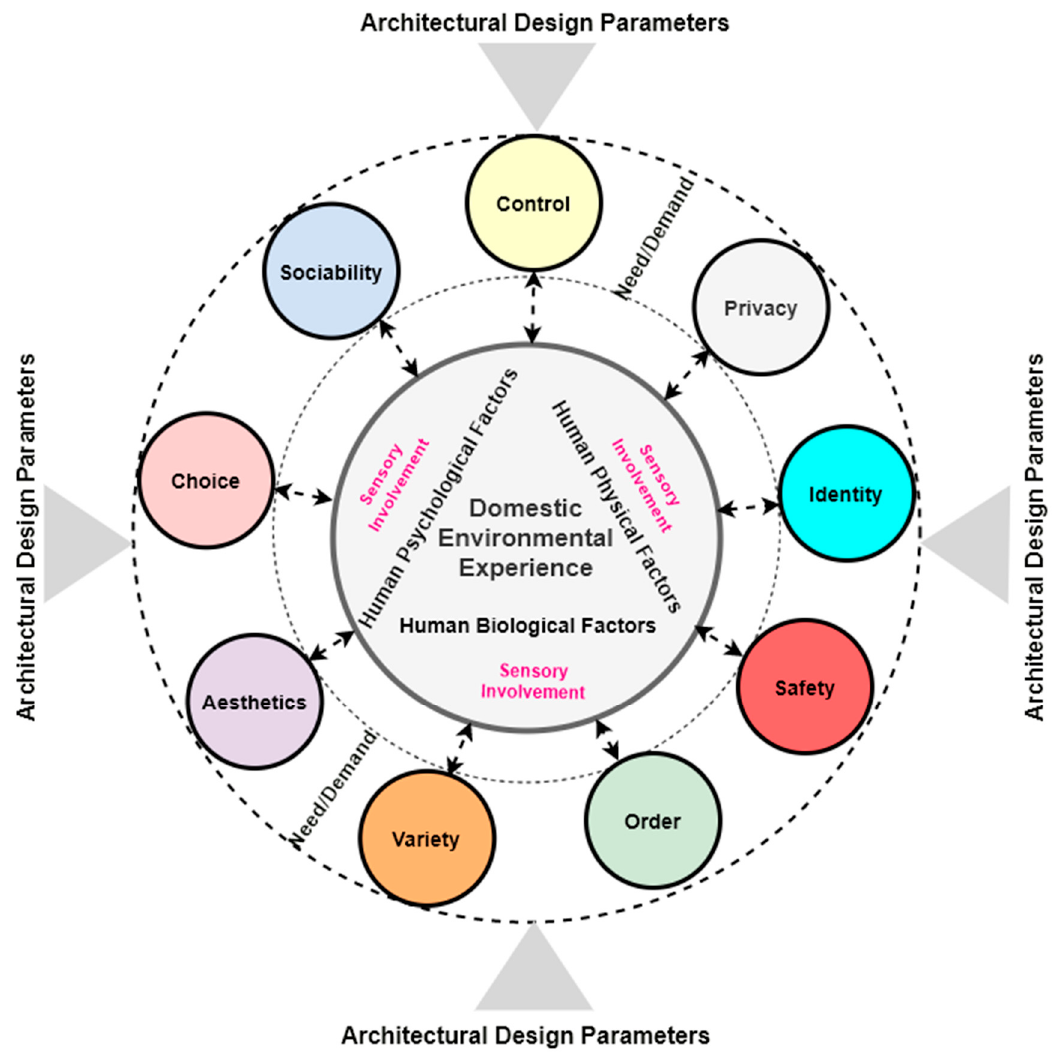
Figure 10. Thematic correlation diagram of domestic environmental experience.